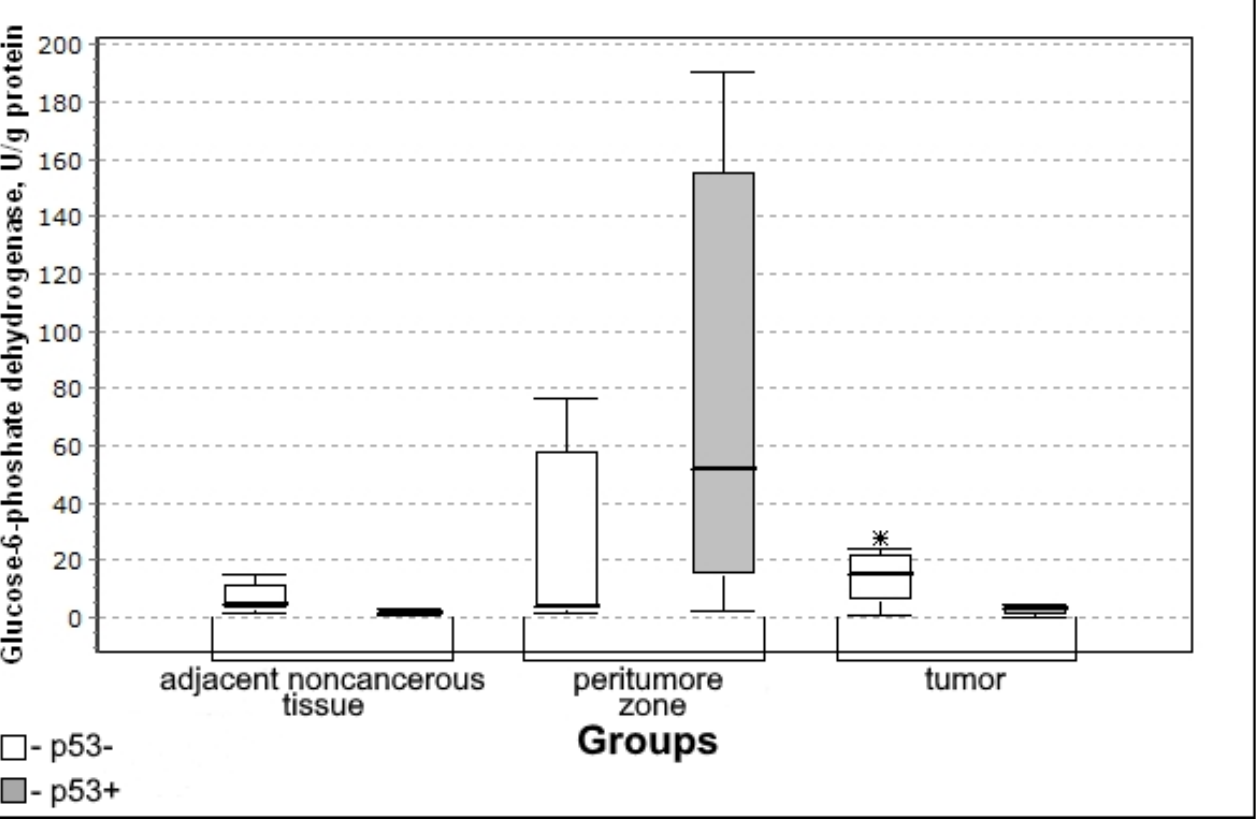
Figure 4. Medians and interquartile ranges (IQR) of the activity of the glucose-6-phosphate dehydrogenase in the tissue of gliomas depending on the expression of the tumor suppressor of p53 protein (p53 + n = 12; p53 − n = 8). Statistics are reported * p < 0.05. Glucose-6-phosphate dehydrogenase activity in the tumor was significantly lower in the group with the expression of the tumor suppressor protein p53 (U-criterion of Mann–Whitney p = 0.04; Kolmogorov–Smirnov criterion p = 0.02) compared to the group without p53 expression.